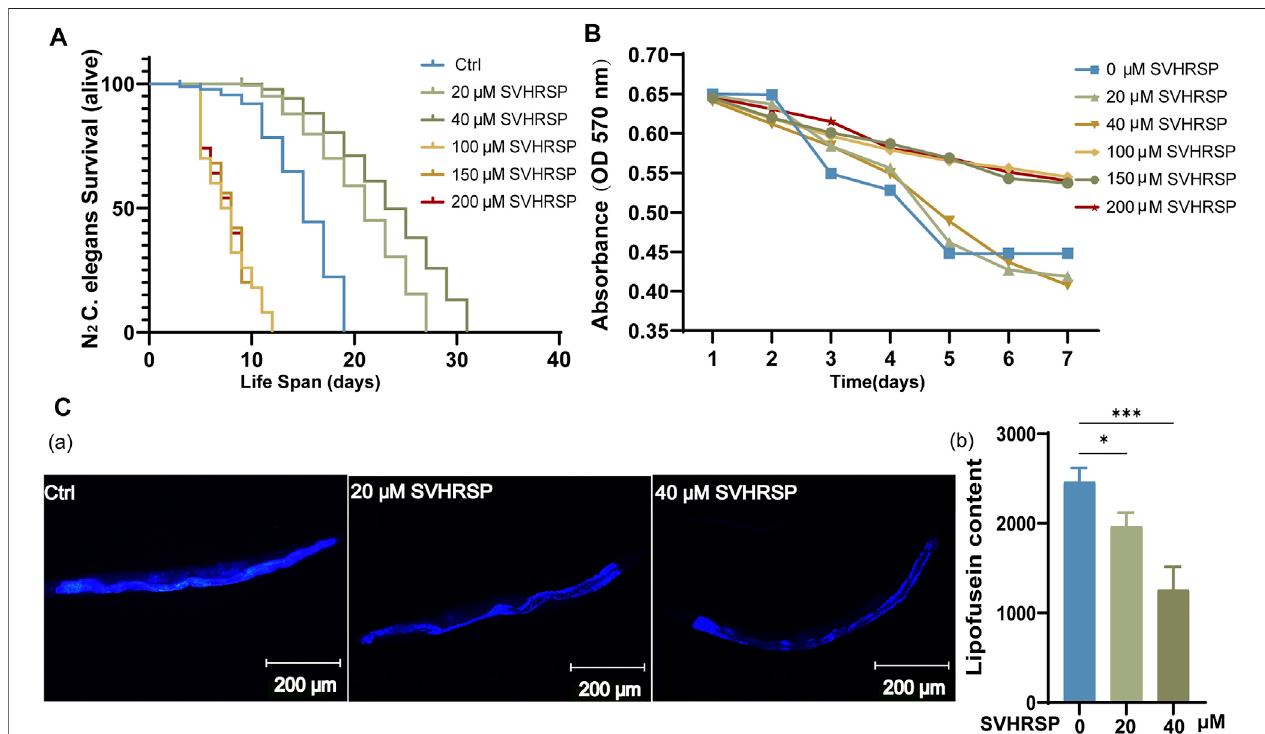
FIGURE1| Scorpionvenomheat – resistantsynthesizedpeptide(SVHRSP)extendsthelifespanofC. elegans . (A) survivalcurveof C.elegans N 2 at20 ° Ctreatment with 20-, 40-, 100-, 150-, or 200- μ mol/L SVHRSP or with ddH 2 O (control) starting from the L4 stage (day 0), the survival number of worms in each group was recorded until all worms died; 40- μ Mol/L SVHRSP appeared to extend the longest lifespans (*** p < 0.001, log-rank test). (B) effects of SVHRSP on food intake in N 2 worms. Surplus E. coli OP50 was detected by OD 600. Data were analyzed by ordinary one-way analysis of variance (ANOVA) using Prism 9.0. Values are presented as mean ± SEM. * p < 0.05. (C) representative images of C. elegans showing the accumulation of auto fl uorescent lipofuscin treatment with SVHRSP or not. The scale bar was200 μ m.Total fl